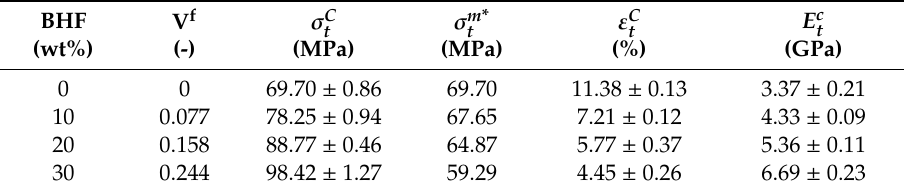
Table 1. Tensile characteristics of the BHF-reinforced PA6 composites.